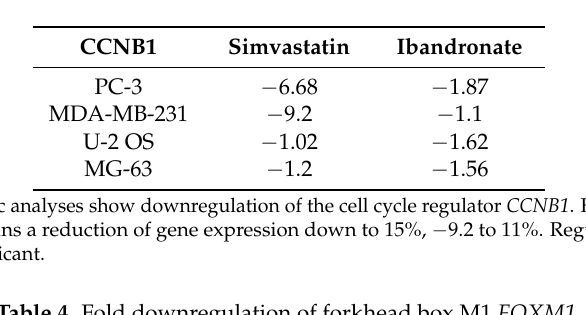
Table 3. Fold downregulation of cyclin B1 CCNB1 .